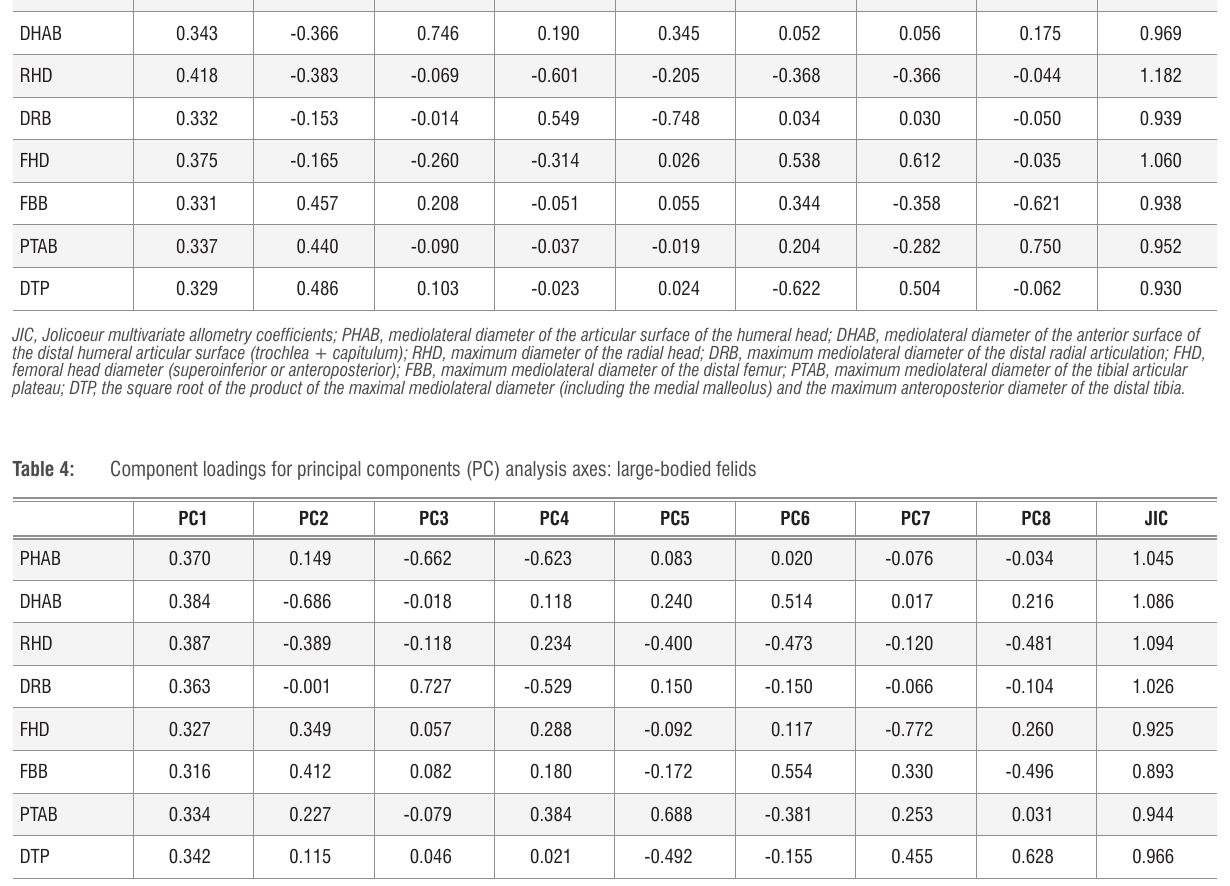
Table 3: Component loadings for principal components (PC) analysis axes: Old World monkeys PC1 PC2 PC3